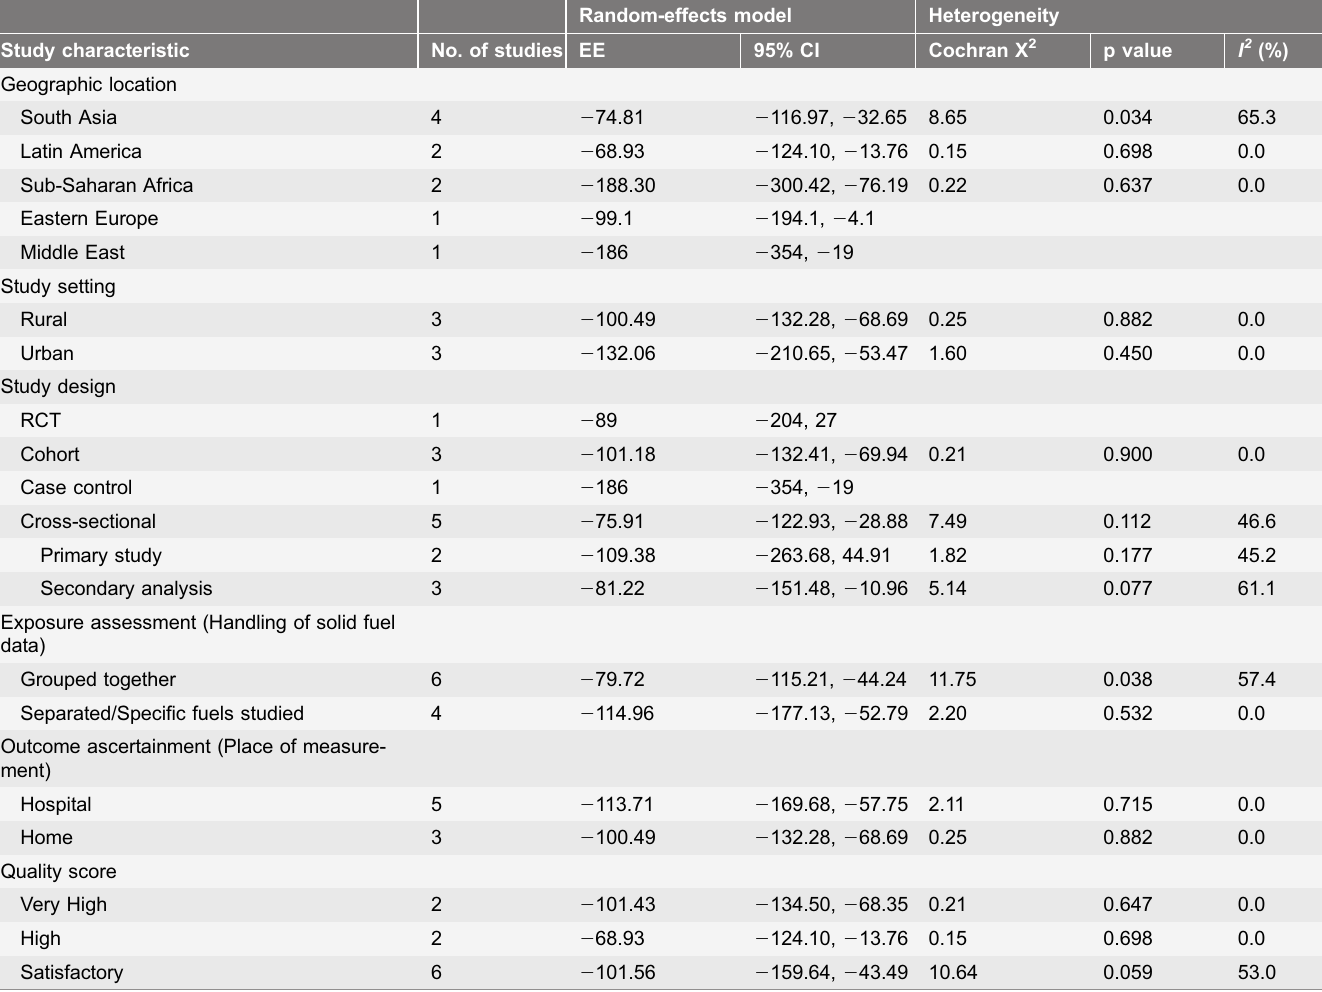
Table 5. Summary-effect estimate for the relation of solid fuel use with birth weight stratified according to the study